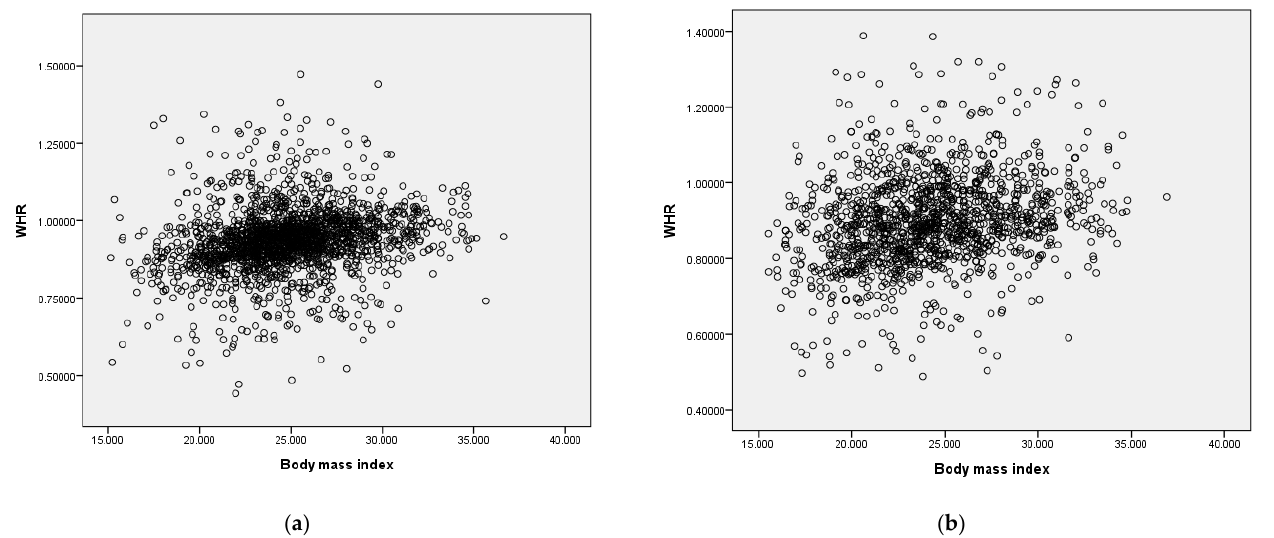
Figure 3. ( a ) Association between BMI and WHR in male patients (R 2 = 0.044, Beta coefficient = 0.773); ( b ) Association between BMI and WHR in female patients (R 2 = 0.055, Beta coefficient = 0.720). Abbreviations: BMI: body mass index, WHR: waist ‐ to ‐ hip ratio.